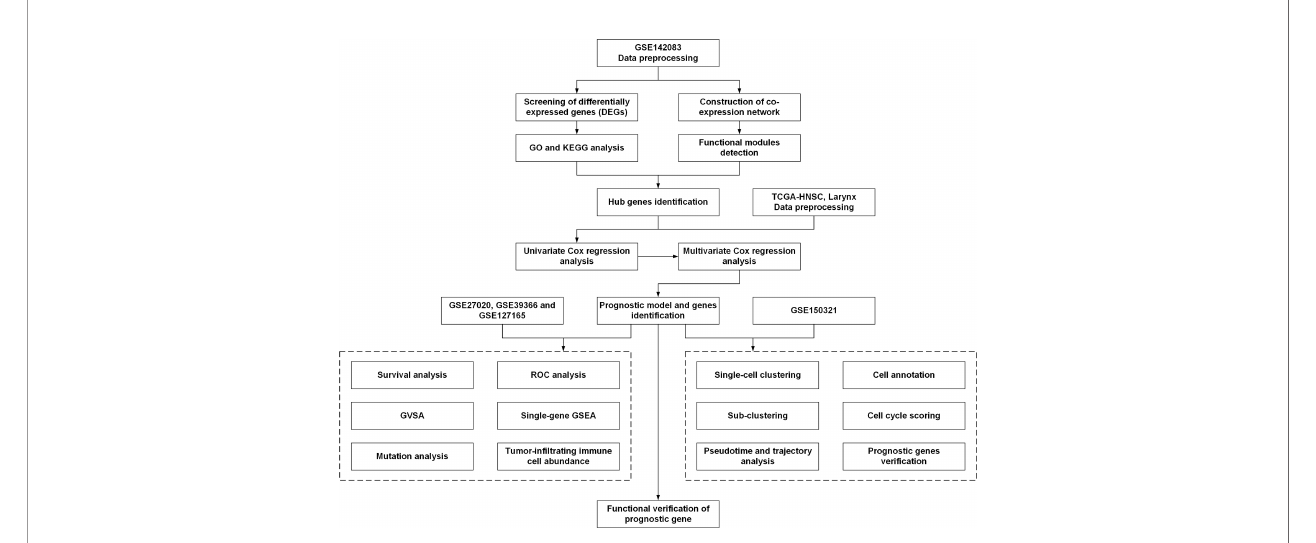
FIGURE 1 | The work fl ow of the present study. DEGs, differentially expressed genes; GO, Gene Ontology; KEGG, Kyoto Encyclopedia of Genes and Genomes; TCGA, The Cancer Genome Atlas; ROC, receiver operating characteristic; GSEA, gene set enrichment analysis; GSVA, gene set variation